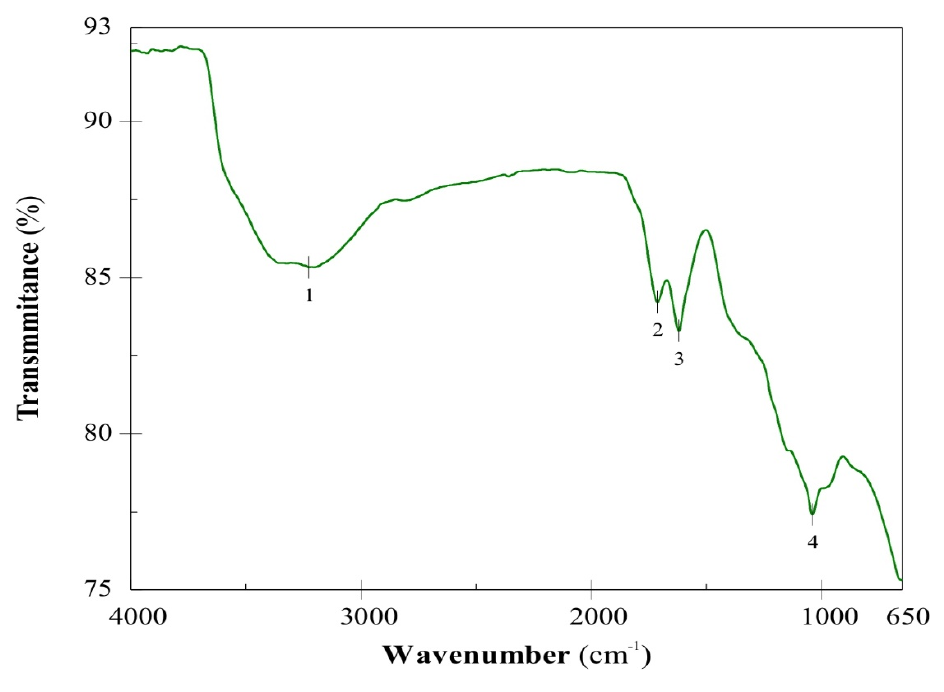
Figure 1. FT / IR spectrum of the graphene oxide Figure 1. FT/IR spectrum of the graphene oxide (GO).